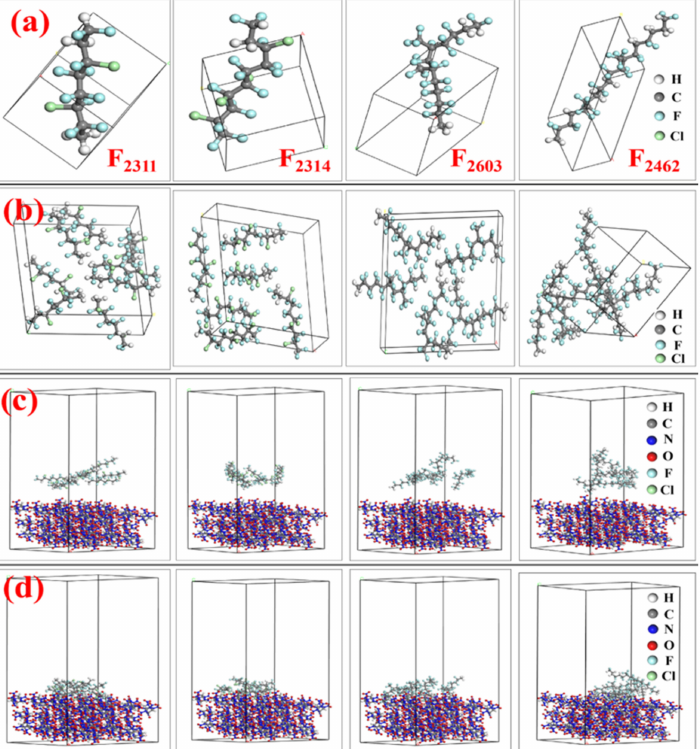
Figure 2. ( a ) Single chain relaxation structure of fluororubber; ( b ) Multichain structure of fluoro rubber; ( c ) Initial structure of fluorine rubber and CL-20 before kinetic simulation; ( d ) Structure of fluorine rubber and CL-20 after the kinetic simulation. Here, gray, white, green, and light blue balls represent carbon, hydrogen, chlorine, and fluorine atoms, respectively. In addition, the dark blue and red balls represent nitrogen and oxygen in the CL-20 structure, respectively.